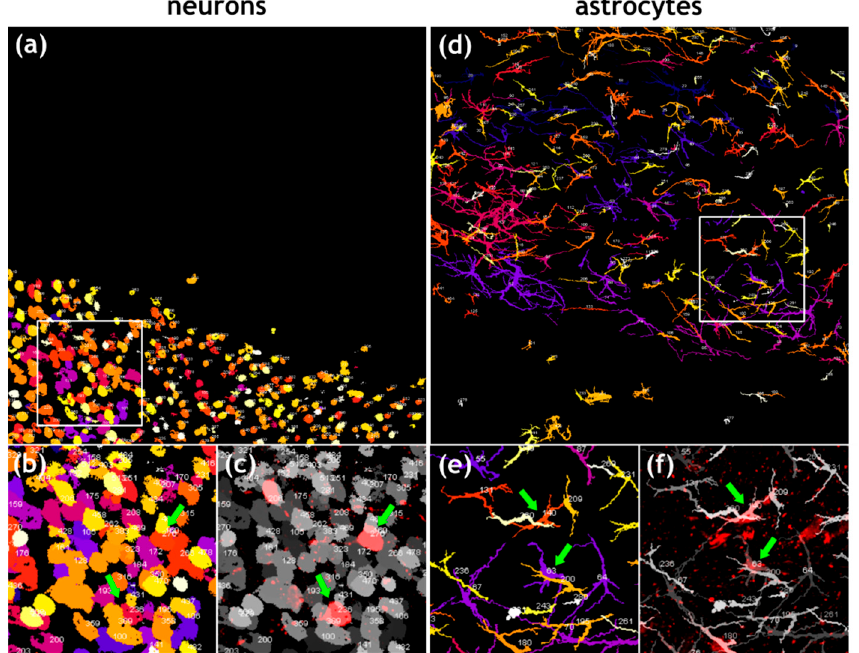
Figure 3. Quantification of RABV-infected neurons and astrocytes. ( a ) Maximum z-projection of objects map for NeuN-positive neurons generated from a confocal z-stack (see Figure 2b). Individual neurons in the z-stack were identified by NeuN-specific fluorescence and converted to objects. Numbers indicate individual cell counts (for improved legibility of the individual numbers, refer to the enlarged details in Supplementary Video S3). n = 762 neurons in a volume of 400 µ m × 400 µ m × 59 µ m. The object colors indicate di ff erent z-positions (darker colors in the back and brighter colors in the front). ( b ) Detail of area indicated by white box in Figure 3a. Green arrows indicate RABV-positive neuron cell bodies. ( c ) Overlay of objects map (greyscale) with RABV P signals allows identification and counting of rRABV Fox-infected neurons. ( d ) Maximum z-projection of objects map for GFAP-positive astrocytes generated from a confocal z-stack (see Figure 2b). Individual astrocytes in the z-stack were identified by GFAP-specific fluorescence and converted to objects. Numbers indicate individual cell counts. n = 272 astrocytes in a volume of 400 µ m × 400 µ m × 59 µ m. The object colors indicate di ff erent z-positions (darker colors in the back and brighter colors in the front). ( e ) Detail of area indicated by white box in Figure 3d. Green arrows indicate RABV-positive astrocytes. ( f ) Overlay of objects map (greyscale) with RABV P signals allows identification and counting of rRABV Fox-infected astrocytes. Table 2. Quantification of rRABV Fox-infected neurons and astrocytes. Results of the analysis of six di ff erent areas of one infected mouse brain. The quantification pipeline of region 2 is depicted in Figure 3. Neurons and astrocytes were segmented, automatically counted, and overlaid with the respective RABV P signals. Infected cells were counted manually. Neurons Astrocytes Region Counted Infected %